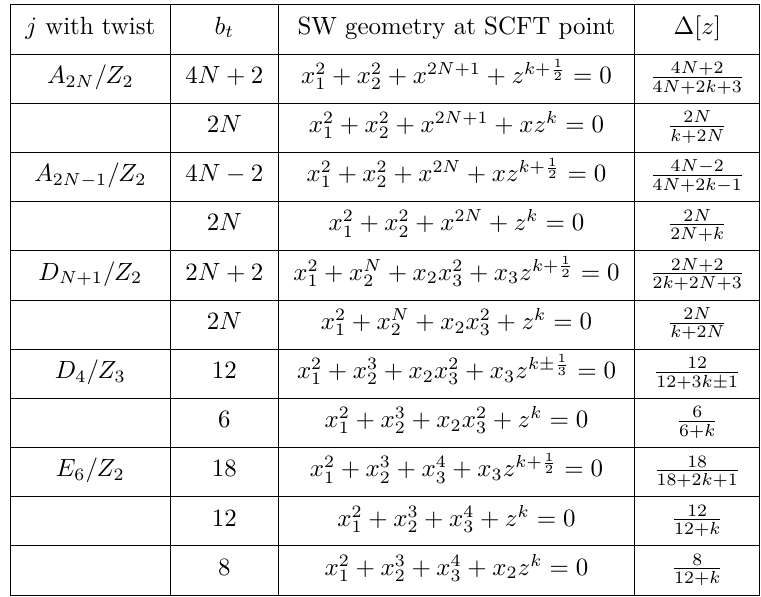
Table 3 . SW geometry of twisted theories at the SCFT point. Here we also list the scaling dimension of coordinate z . All k ’s in this table are integer valued and the power of z coordinate in singularity is equal to k used in equation (3.2). t